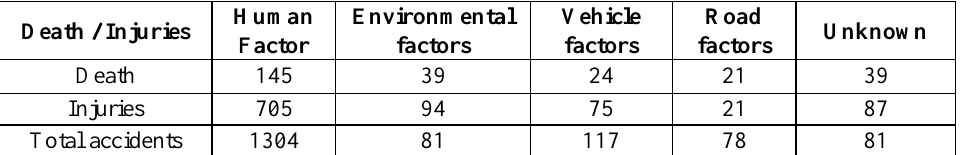
Table 7: Distribution of Accident by Causes with Death and Injuries.